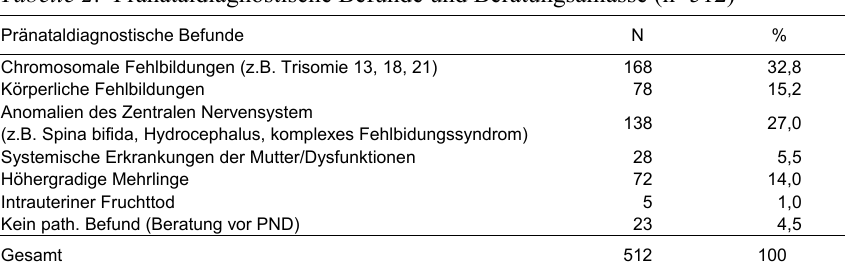
Tabelle 2: Pränataldiagnostische Befunde und Beratungsanlässe